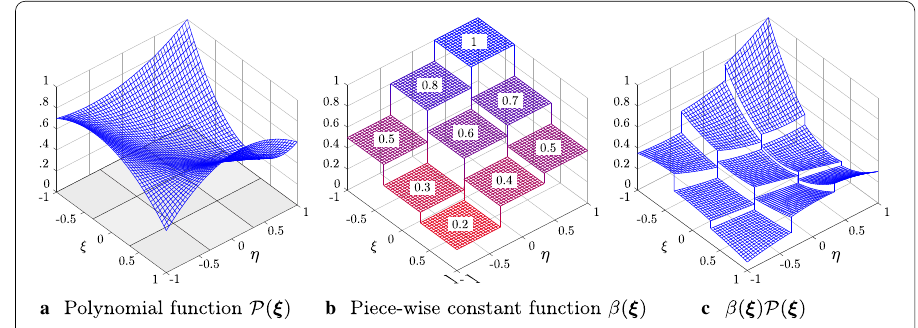
Fig. 3 Example for the discontinuous integrals in the approach by Yang et al. [42–44]. For the definition of P see Fig. 2